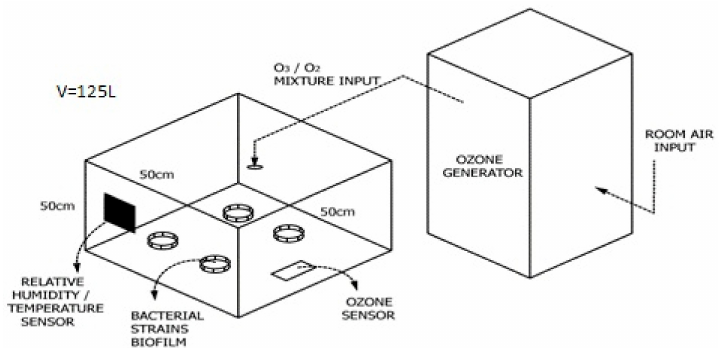
Figure 1. Ozonation in vitro model